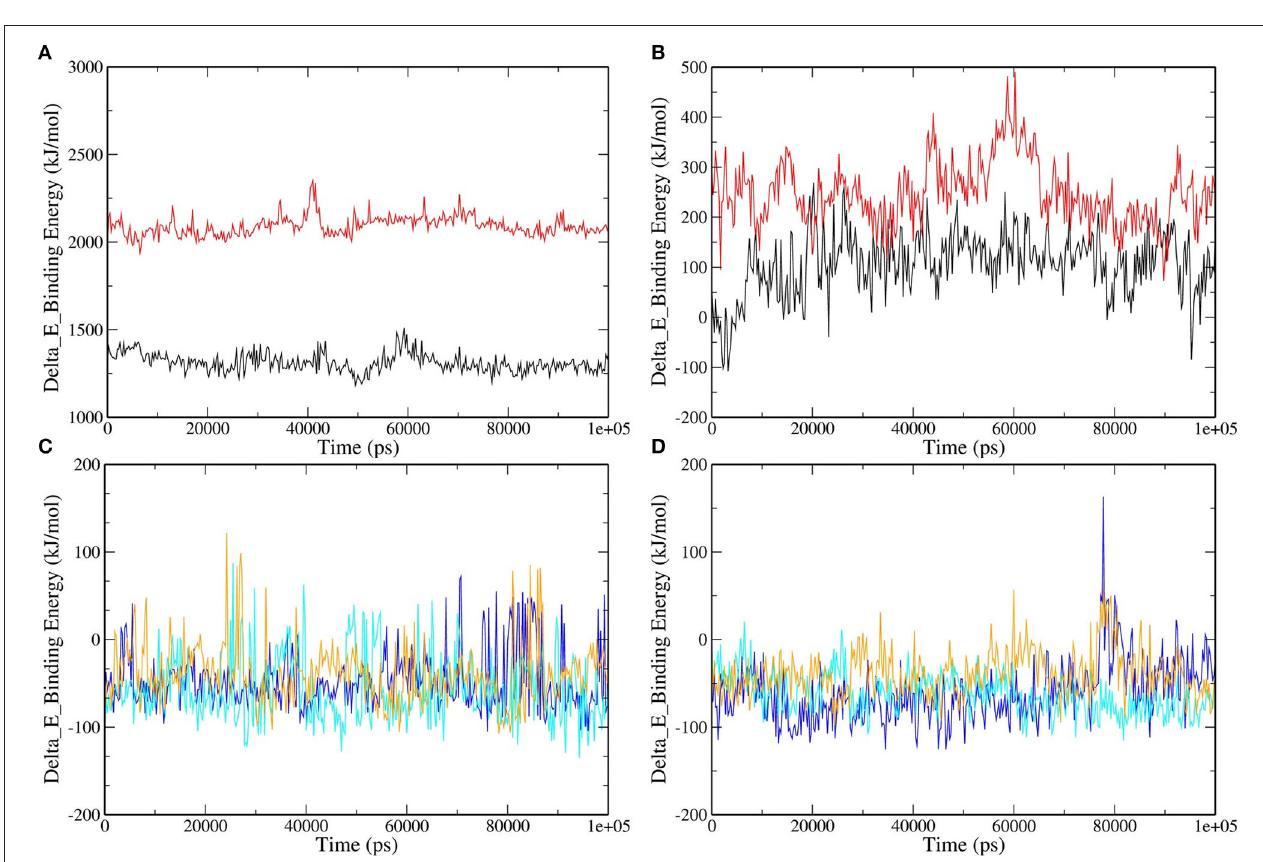
FIGURE 6 | Binding free energy represented graphically for RdRp protein and color scheme as follows: (A) RNA–Remdesivir (black), RNA–Favipiravir (red). (B) RdRp–Remdesivir (black), RdRp–Favipiravir (red). (C) RNA–epicatechin-3,5-di-O-gallate (blue), RNA–epigallocatechin-3,5-di-O-gallate (cyan), RNA–epigallocatechin-3,4-di-O-gallate (orange). (D) RdRp–epicatechin-3,5-di-O-gallate (blue), RdRp–epigallocatechin-3,5-di-O-gallate (cyan), RNA–epigallocatechin-3,4-di-O-gallate (orange).